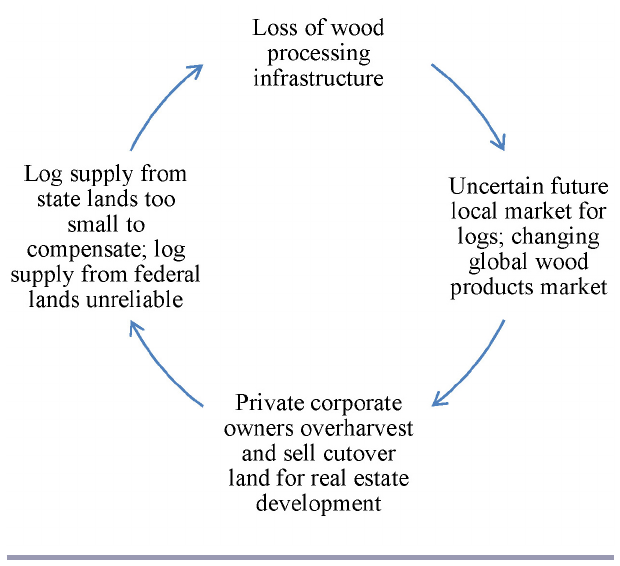
Fig. 9. Positive feedback loop associated with loss of mill infrastructure.